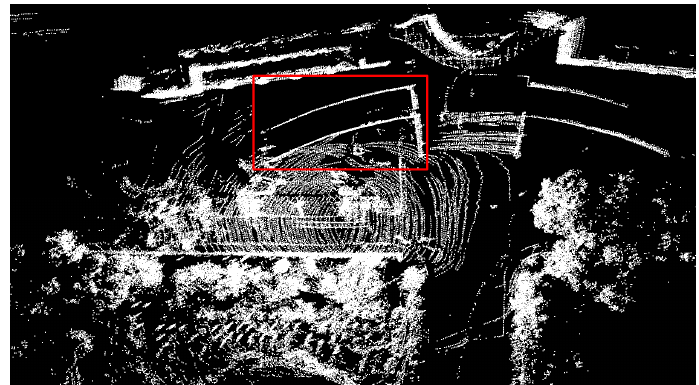
Figure 16. The real scene of outdoor experiment locatio n . The red line represents the driving route of our vehicle and the yellow rectangle is the place of the deceleration zone.